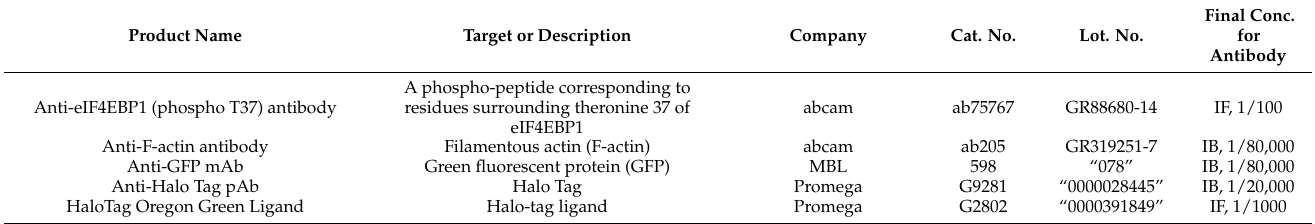
Table 1. Antibodies and